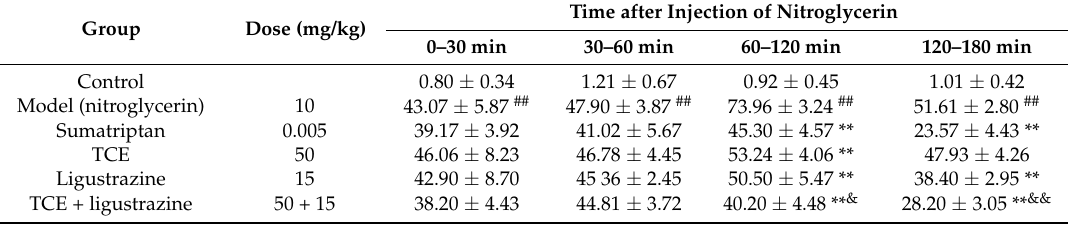
Table 1. The effects of total coumarin extract (TCE) and ligustrazine on the frequency of head scratching in rats with migrine ( n = 6).